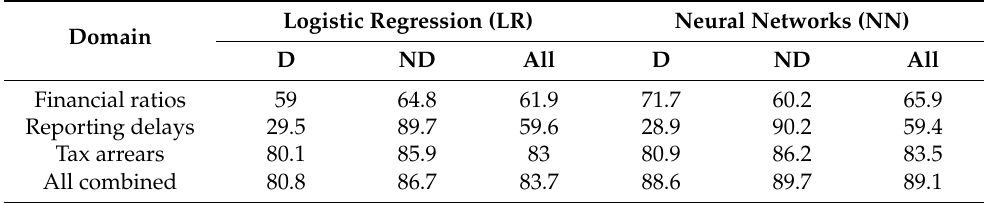
Table 8. Domain-based and across-domain multivariate prediction accuracies